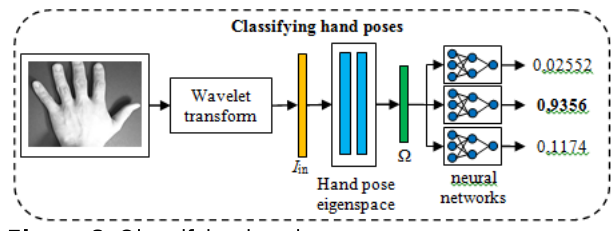
Figure 8. Classifying hand